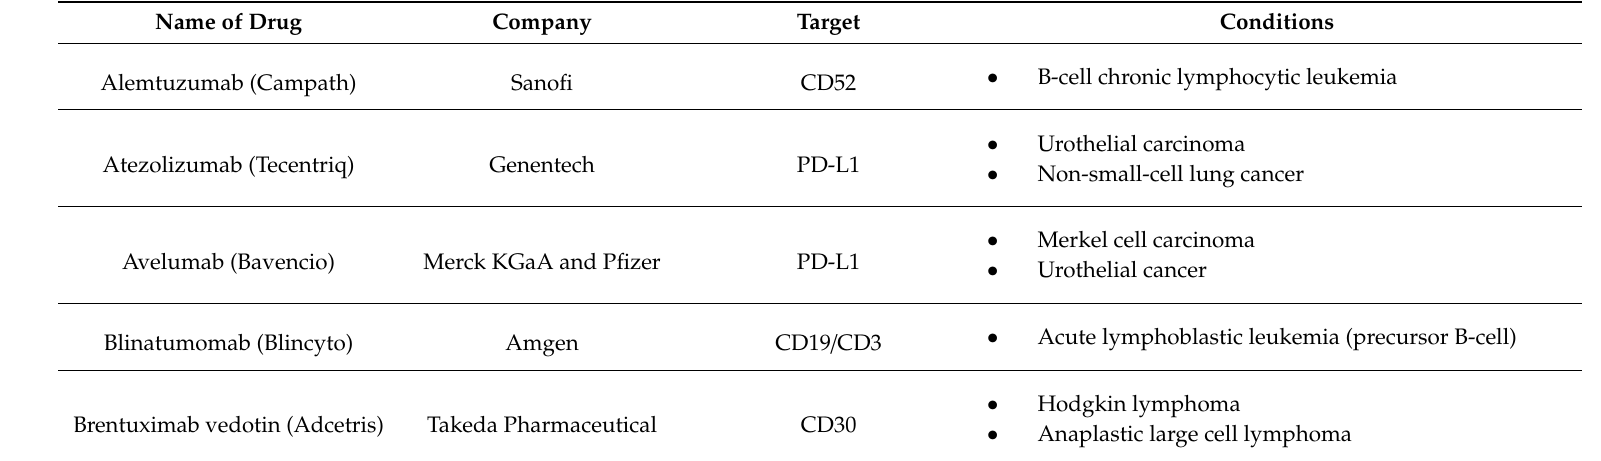
Table 3. FDA-approved drugs for